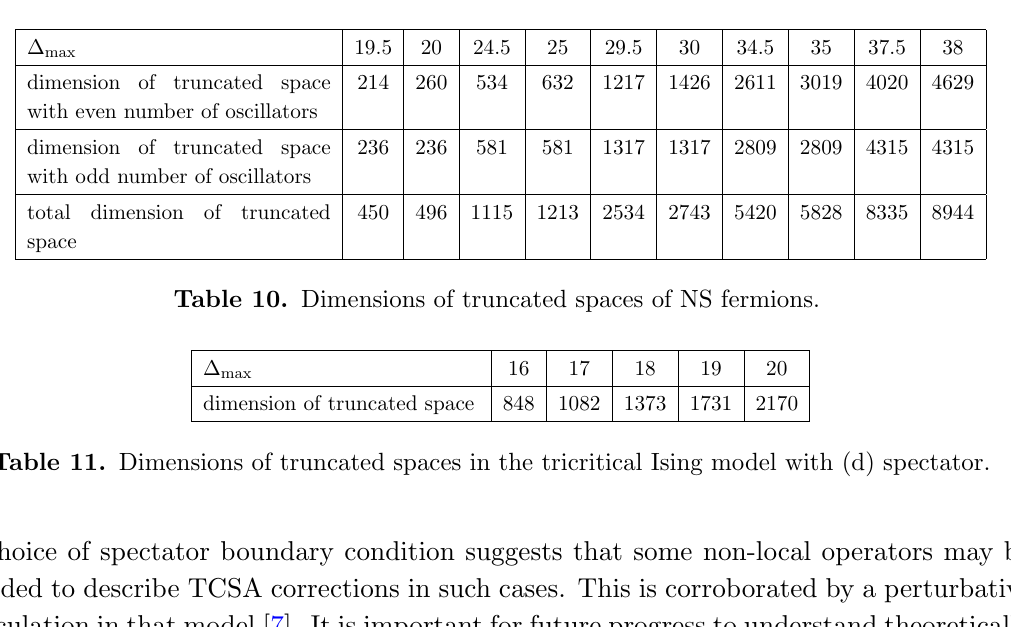
Table 9. Dimensions of truncated spaces of Ramond fermions.